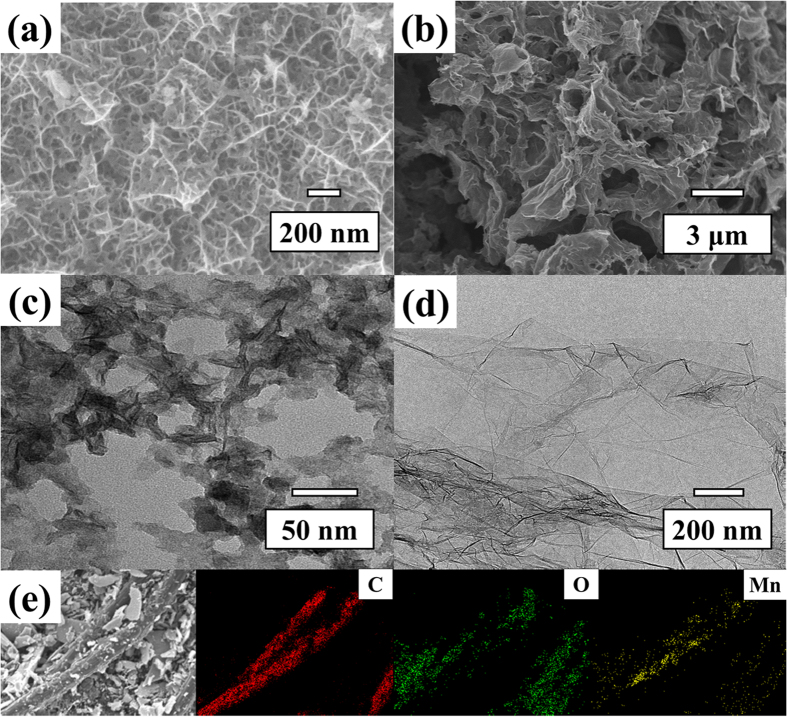
FE-SEM images of (a) MnO2 and (b) N-rGOae as well as TEM images of (c) MnO2 and (d) N-rGOae and (e) EDX mapping of MnO2/c-CFP mainly containing C, O, and Mn elements.